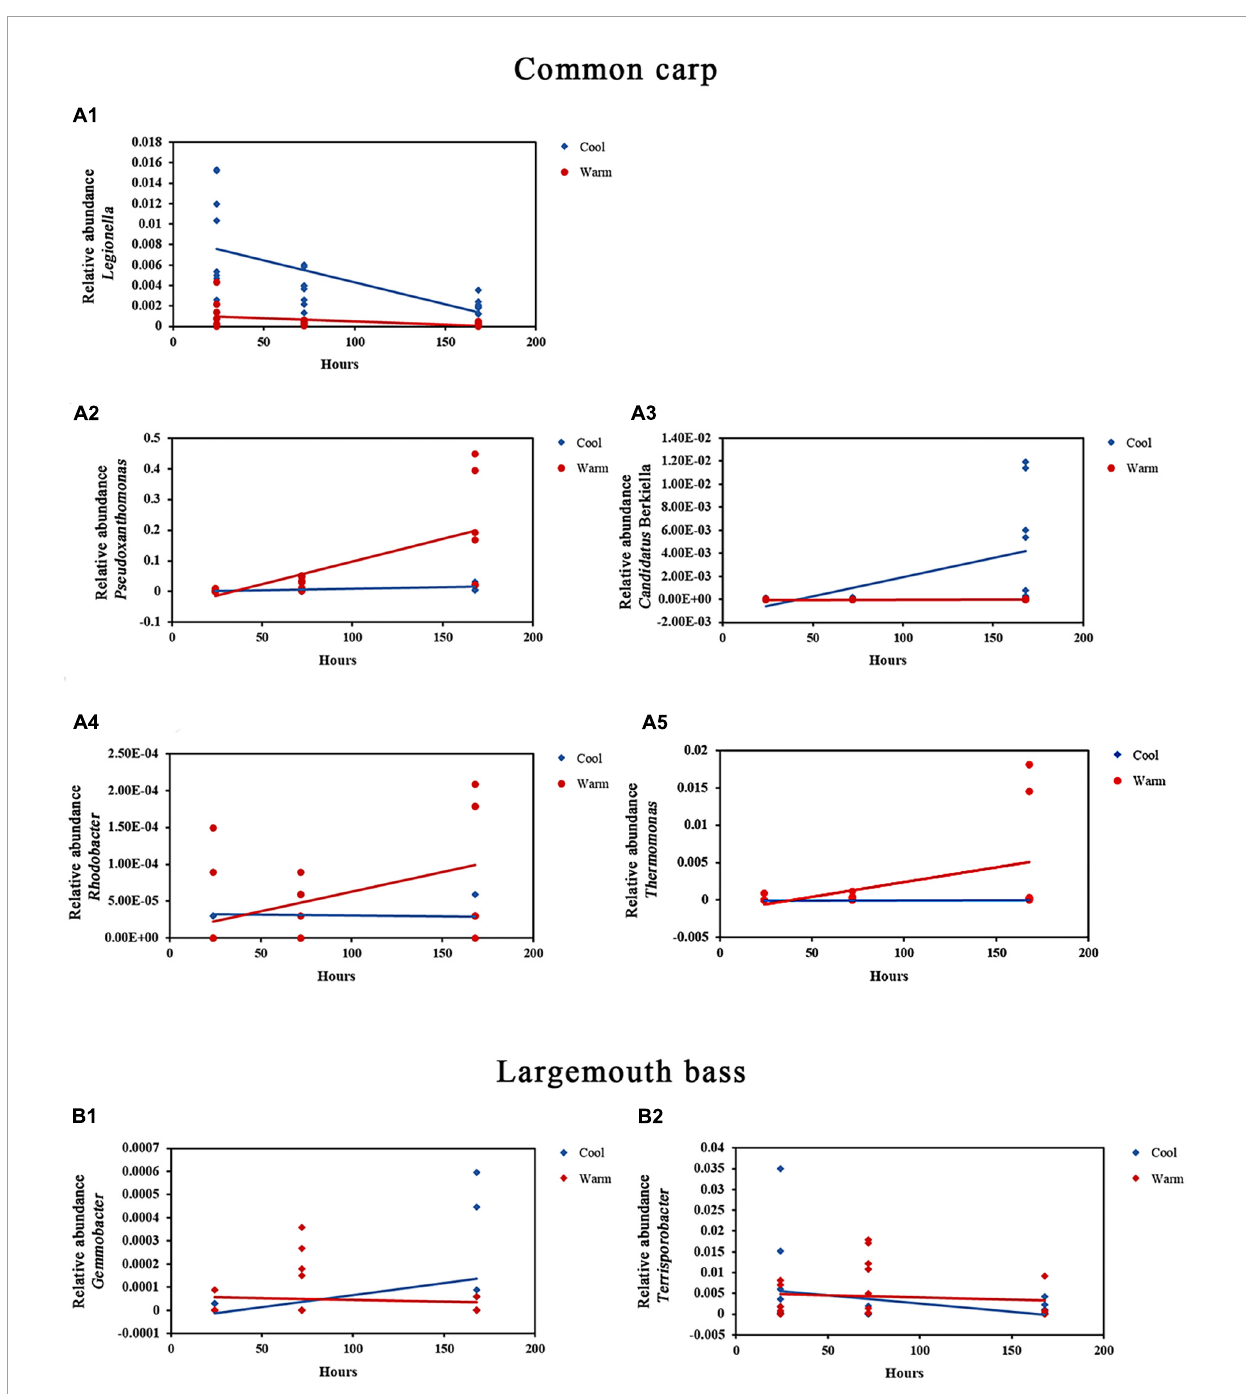
FIGURE2 Relative abundances of bacterial genera in the gut microbial communities of common carp and largemouth bass that were significantly affected by the interaction of temperature and time. (A1–A5) Relative abundance of Legionella , Pseudoxanthomonas , Candidatus Berkiella, Rhodobacter , and Thermomonas in common carp gut microbial communities in warm and cool treatments over time, respectively (all FDR p < 0.05). (B1,B2) Relative abundance of Gemmobacter and Terrisporobacter in largemouth bass gut microbial communities in warm and cool treatments over time, respectively (all FDR p <